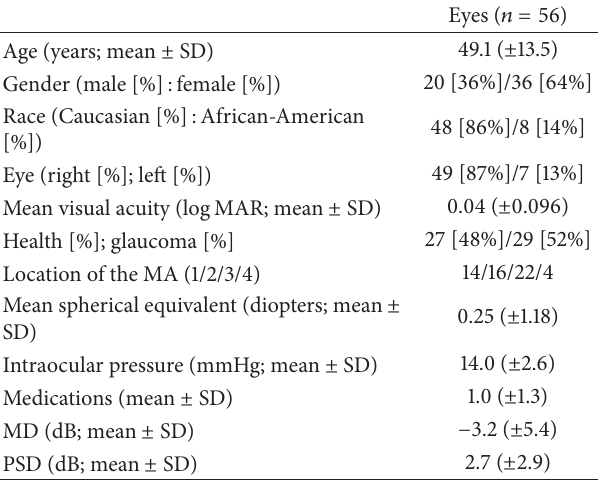
Table 1: Demographic characteristics of the eyes with complete or partial misalignments included in the